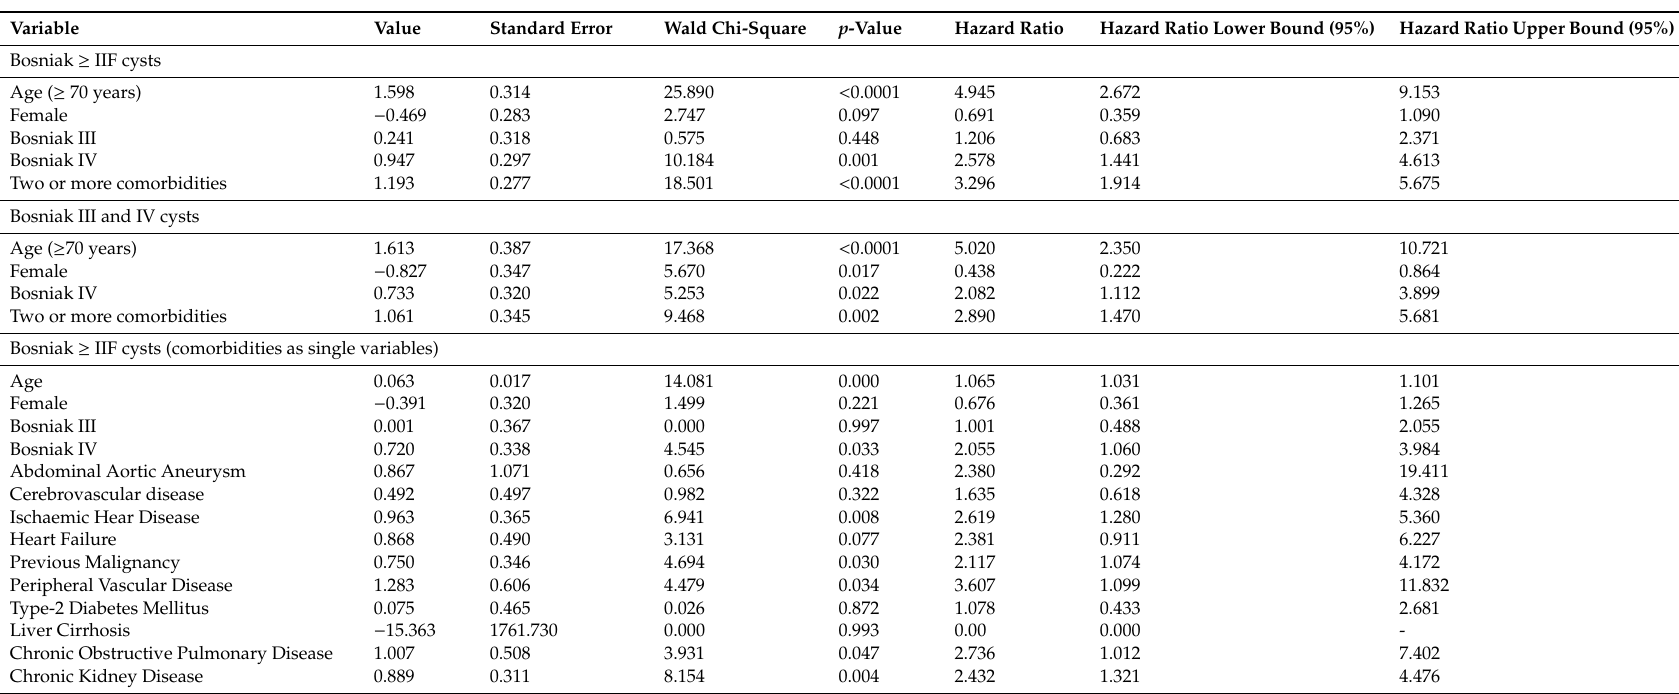
Table A2. Cox proportional hazards model—associations between variables and death (Bosniak ≥ IIF